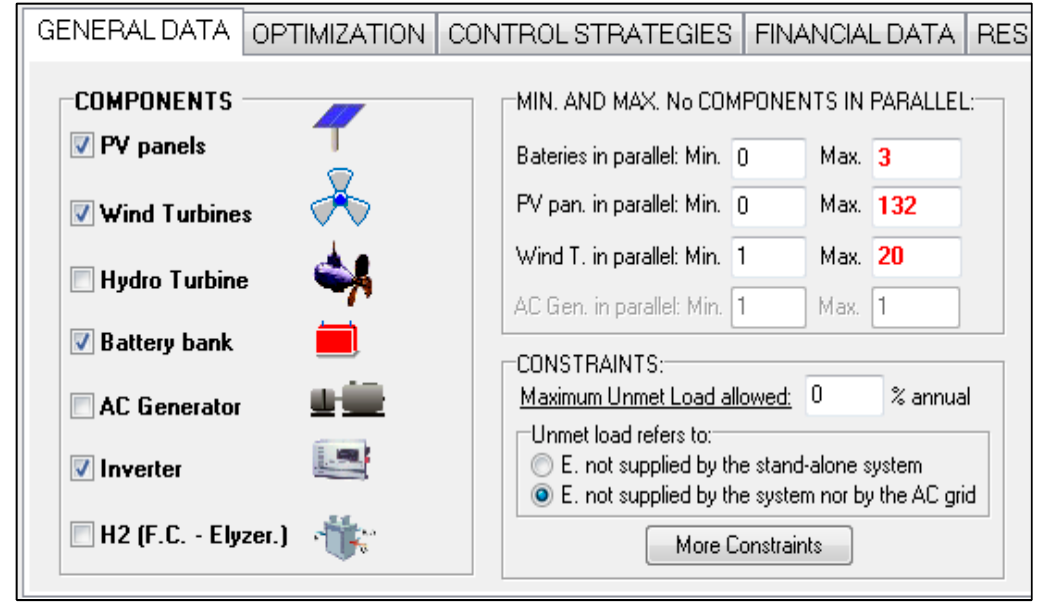
Figure 10. Minimum and maximum number of components chosen by iHOGA for simulation.